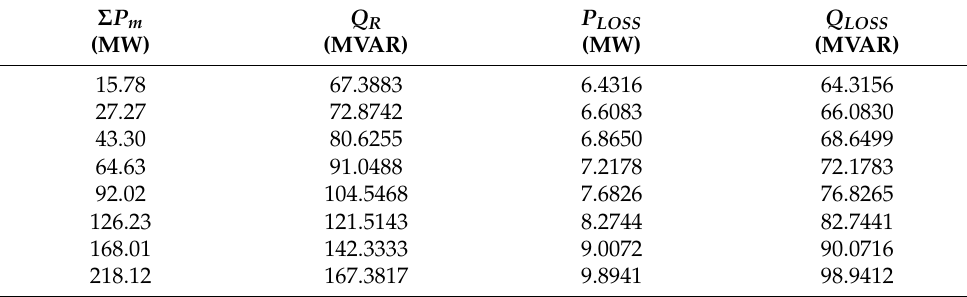
Table 11. DFIG reactive power and losses (PF = 0.95 leading).